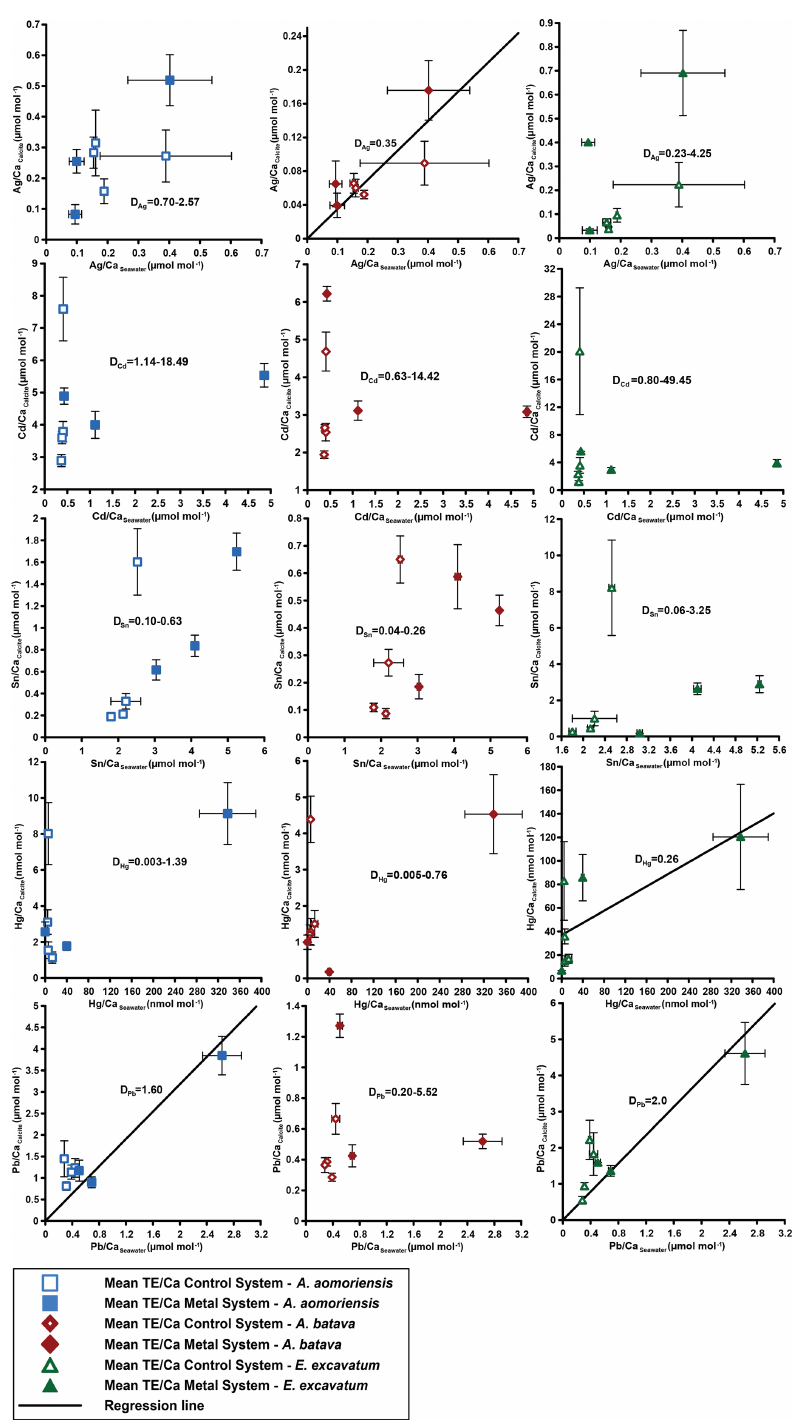
Figure B2. Mean TE / Ca values in the foraminiferal calcite versus the mean TE / Ca values in the corresponding culturing medium without phase 3. Each data point represents the mean value of all laser ablation ICP-MS measurements on single foraminiferal chambers built up during the individual culturing phase plotted against the mean metal concentrations in the seawater averaged over the culturing phase (Table 3). Error bars symbolise the standard error of the mean. The linear regression line is based on the calculations excluding phase 3 and is only displayed when elements showed a significant correlation between seawater and calcite. D TE ’s of E. excavatum are considered without values for phase 0 as only data from one newly formed chamber are available. All values can be found in Table